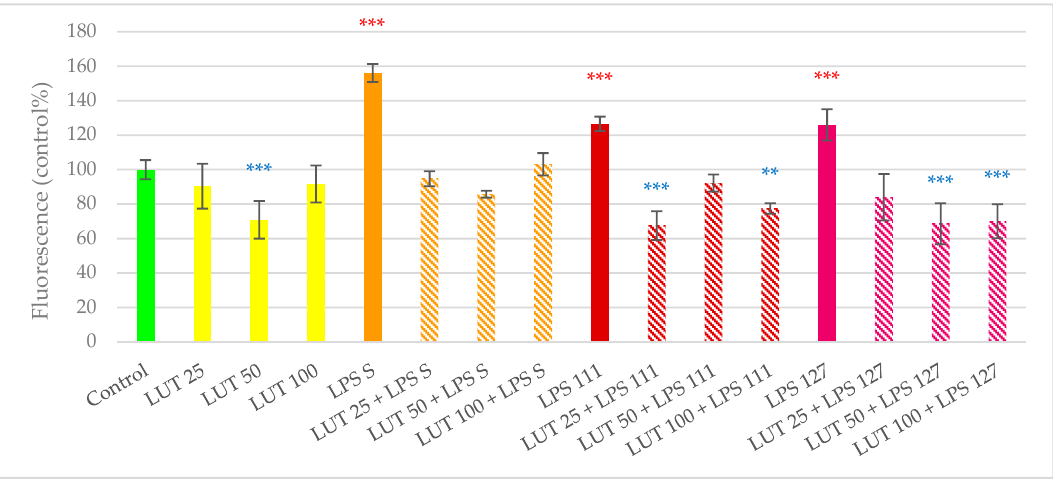
Figure 4. Amount of intracellular reactive oxygen species after treatment with bacterial endotoxin (LPS), luteolin (LUT) and their combinations. Control—plain cell culture medium treatment; LUT 25: 25 μ g/mL LUT; LUT 50: 50 μ g/mL LUT; LUT 100: 100 μ g/mL LUT; LPS S: S . Typhimurium endotoxin